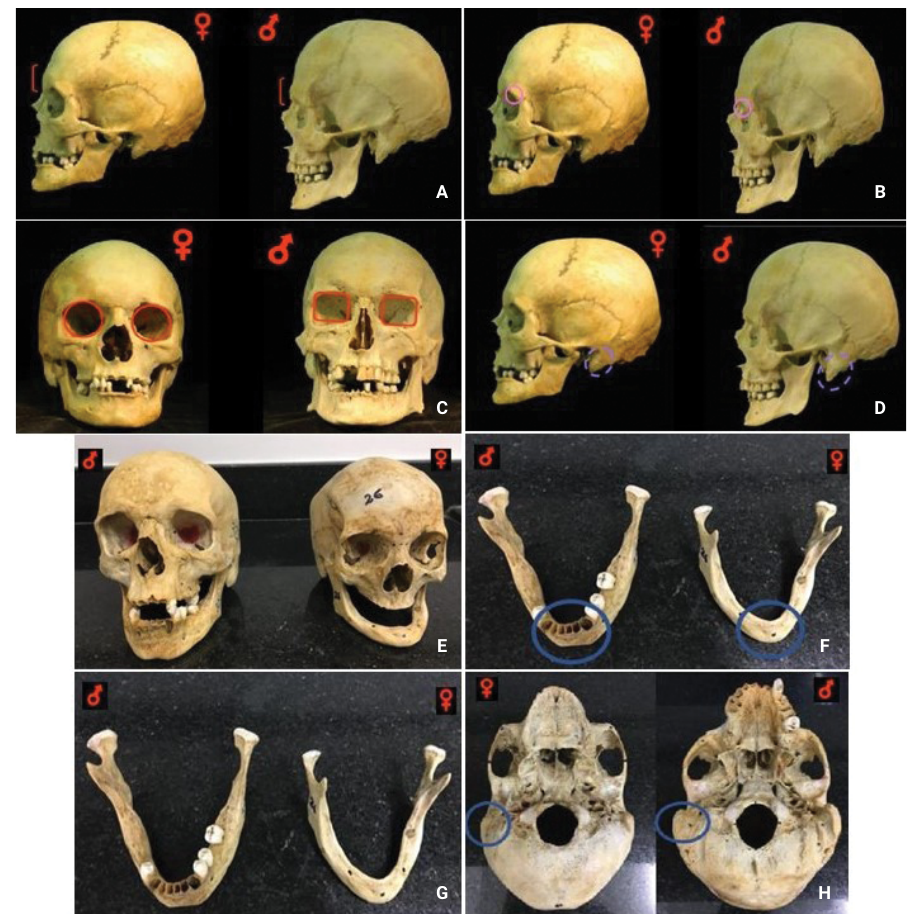
Figure 1. A: Glabella (Gl); B: Supraorbital region (Rs) and Supraorbital protuberances (Pts); C: Orbits (Orb); D: Mastoid processes (Pm); E: Angle and lines (At) and Facial physiognomy (Ff); F: Mental eminence (Em); G: Mouth depth (Pb); H: Supramastoid crests and rugosity